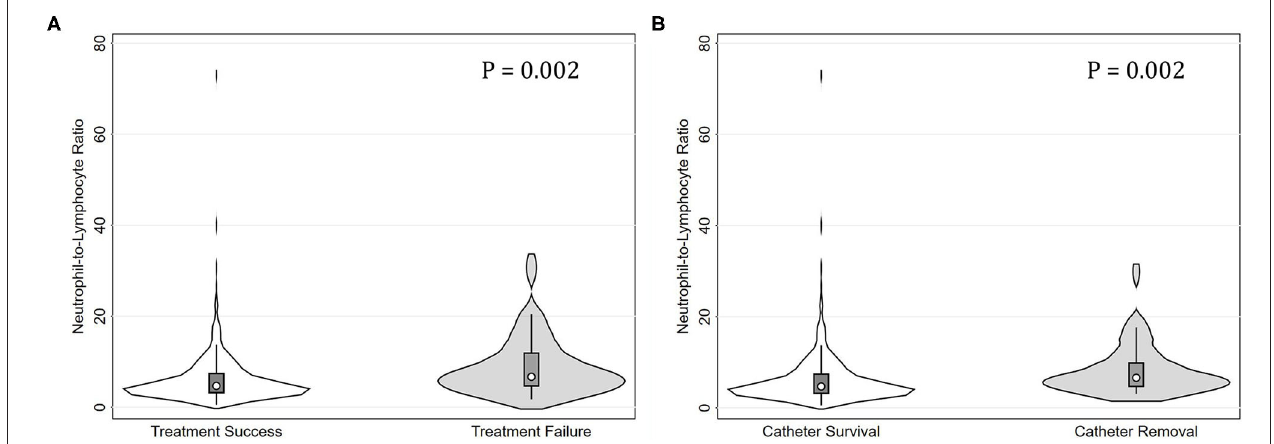
FIGURE 1 | Violin plots for neutrophil-to-lymphocyte ratio (NLR) levels in peritonitis episodes grouped by treatment failure and catheter removal. (A) Episodes with treatment failure had significantly higher NLR levels than those with treatment success ( P = 0.002). (B) Episodes with catheter removal had significantly higher NLR levels than those with catheter survival ( P =